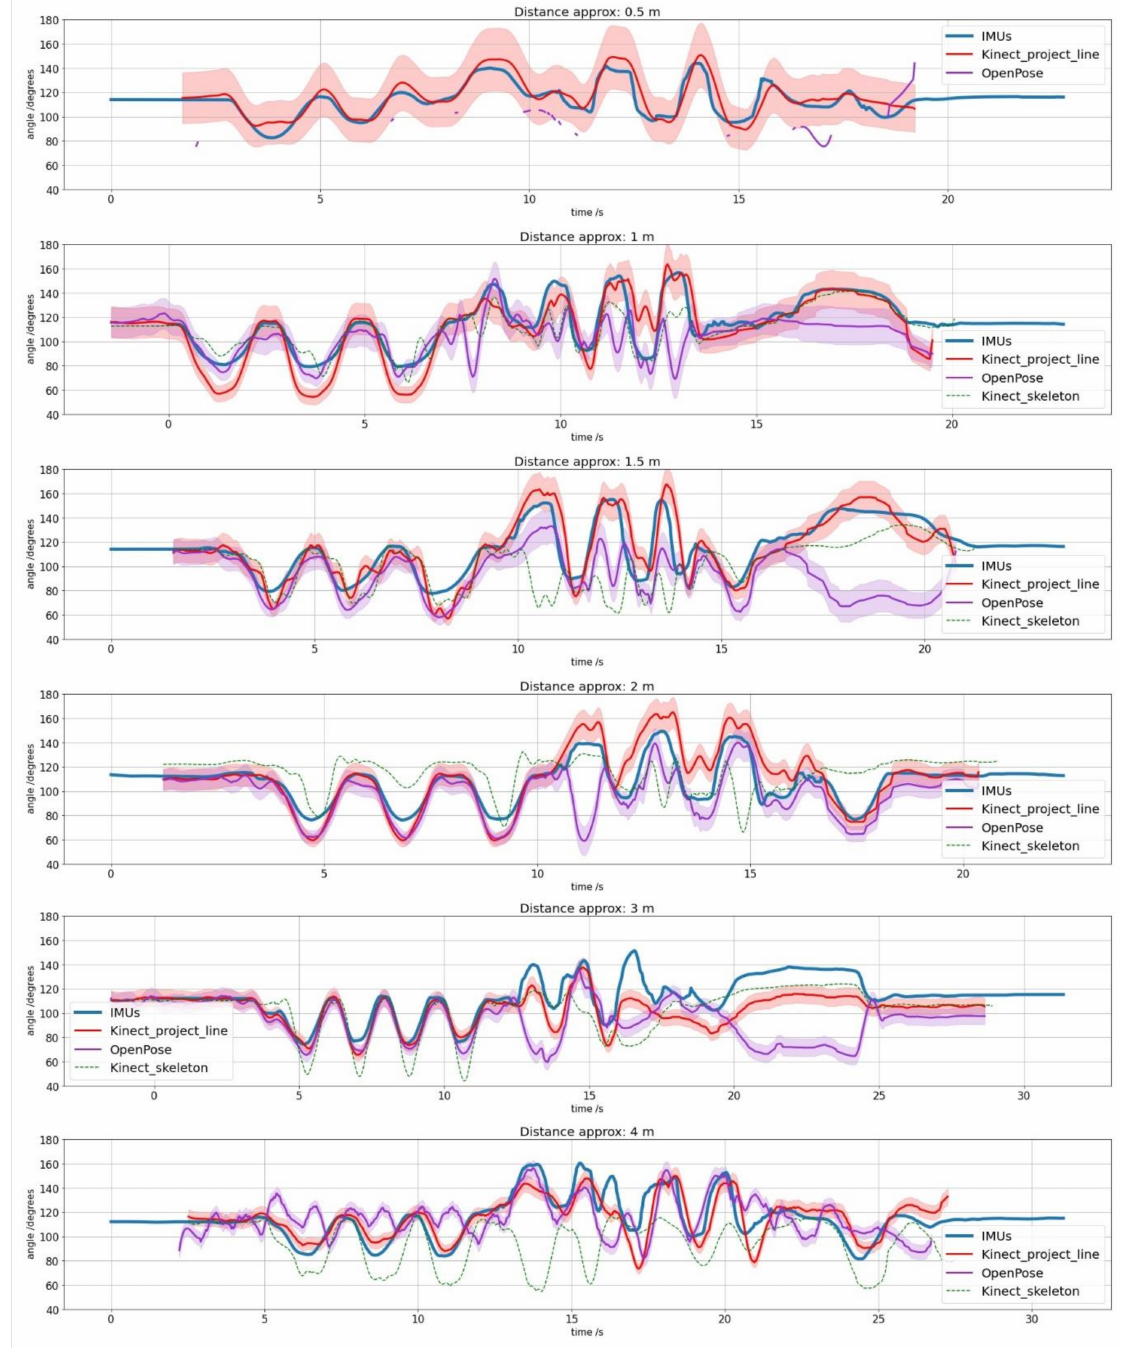
Figure 15. Graph showing the comparison between the ankle angle measured by the Kinect v2 with our projection lines method (red), the ankle angle measured by OpenPose (violet) and the angle measured by the IMUs using Euler’s angles (blue), for different distances in relation to the Kinect, which are: 0.5, 1, 1.5, 2, 3 and 4 m. Red and violet shaded area is the Kinect angle error following Equation (20). In addition, when it exists, the ankle angle measured with the default skeleton generated by the Kinect (green) is also